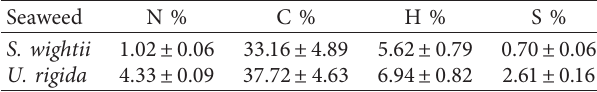
Results are expressed as mean ± SD ( n �